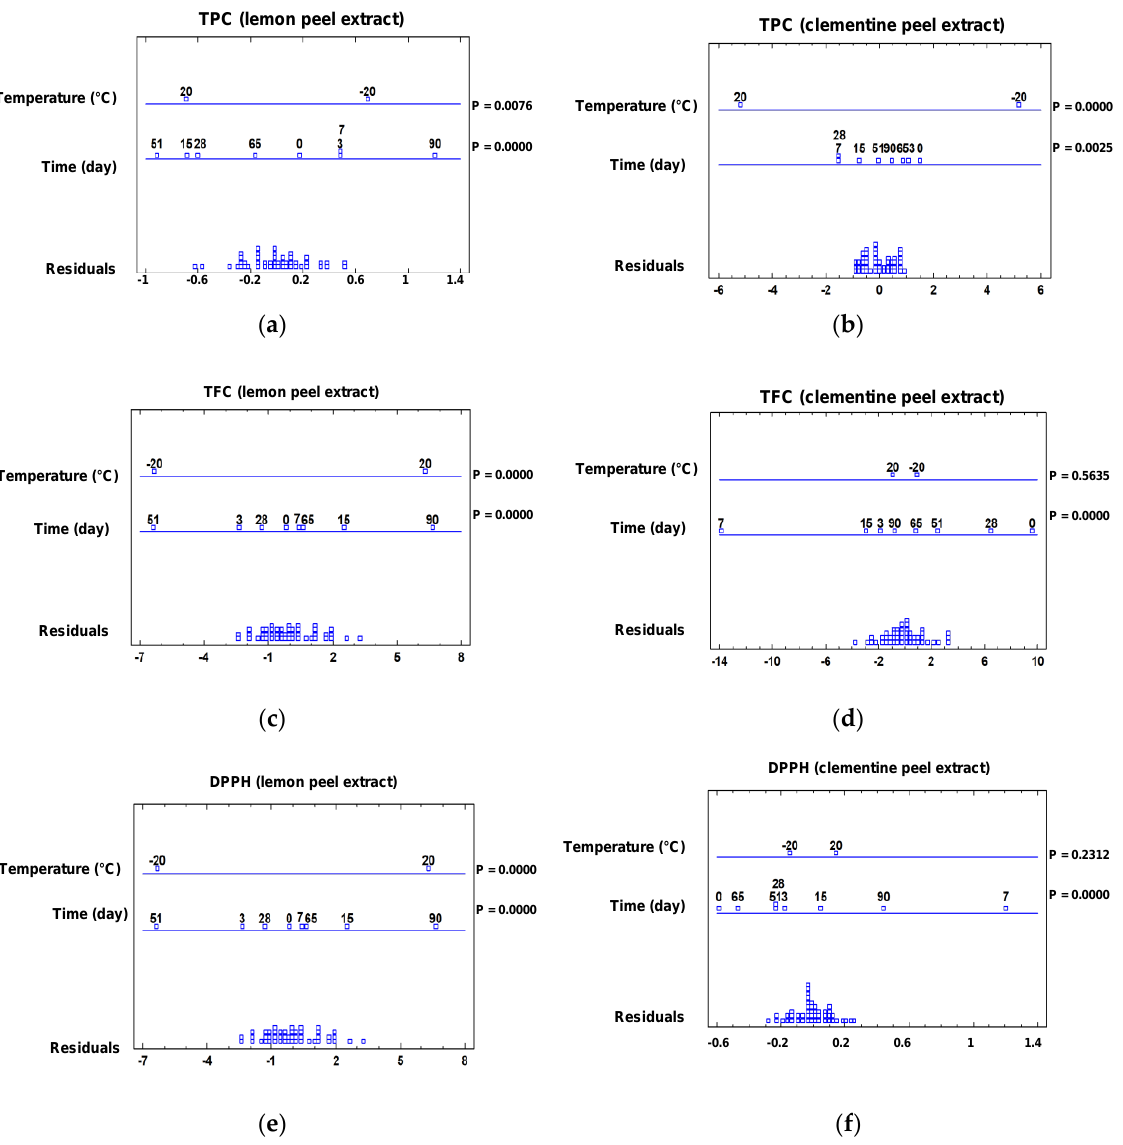
Figure 5. Multifactorial ANOVA plots showing the influence of storage time and temperature on: ( a ) TPC in lemon peel extracts, ( b ) TPC in clementine peel extracts, ( c ) TFC in lemon peel extracts, ( d ) TFC in clementine peel extracts, ( e ) DPPH in lemon peel extracts, and ( f ) DPPH in clementine peel extracts. p -values (P) lower than 0.05 indicate a statistically significant effect at 95% confidence level.